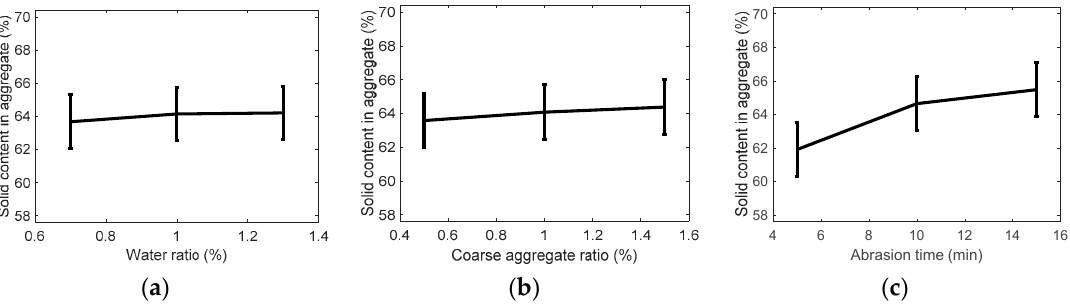
Figure 5. Assumed solid volume of recycled fine aggregate by variance analysis: ( a ) water ratio; ( b ) coarse aggregate ratio; and ( c ) abrasion crusher time.